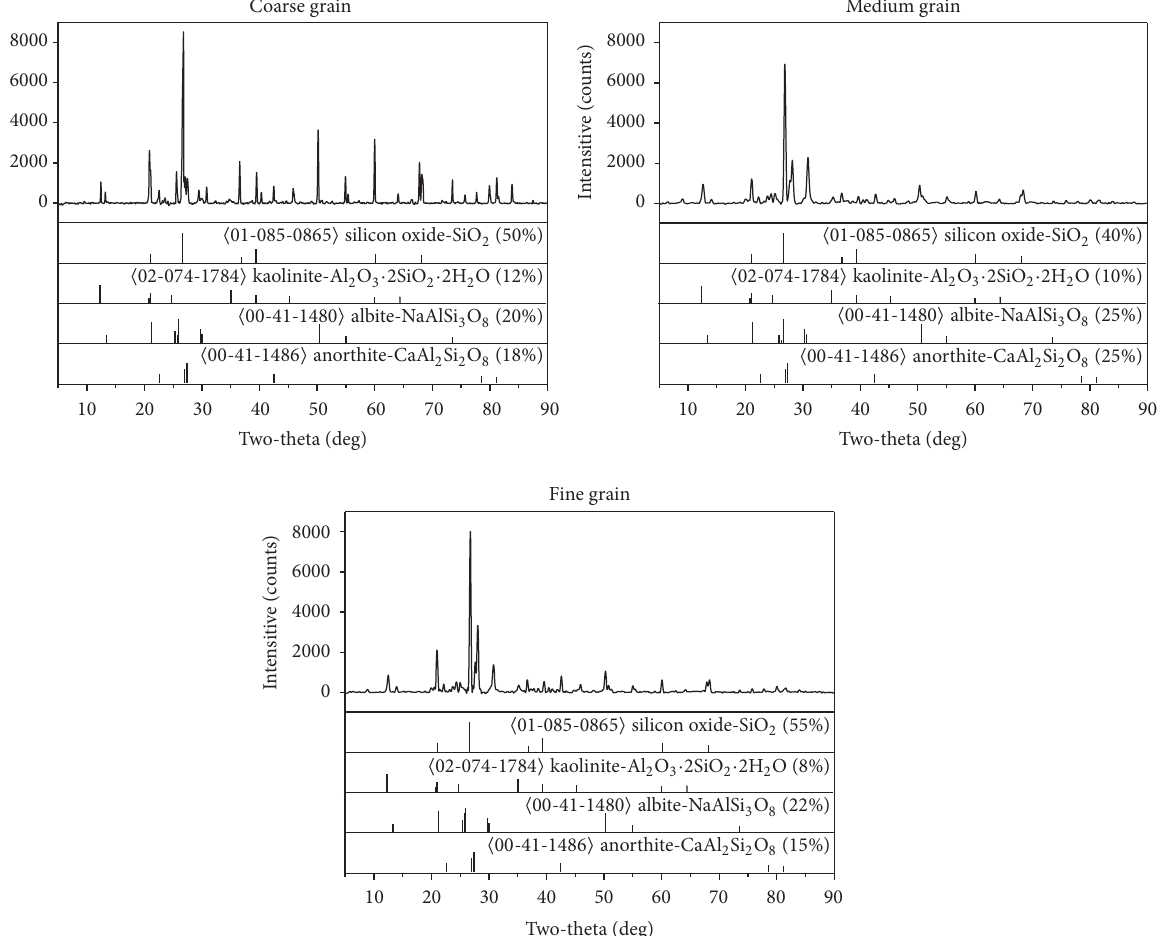
Figure 5: XRD graphs of sandstones with three kinds of grain